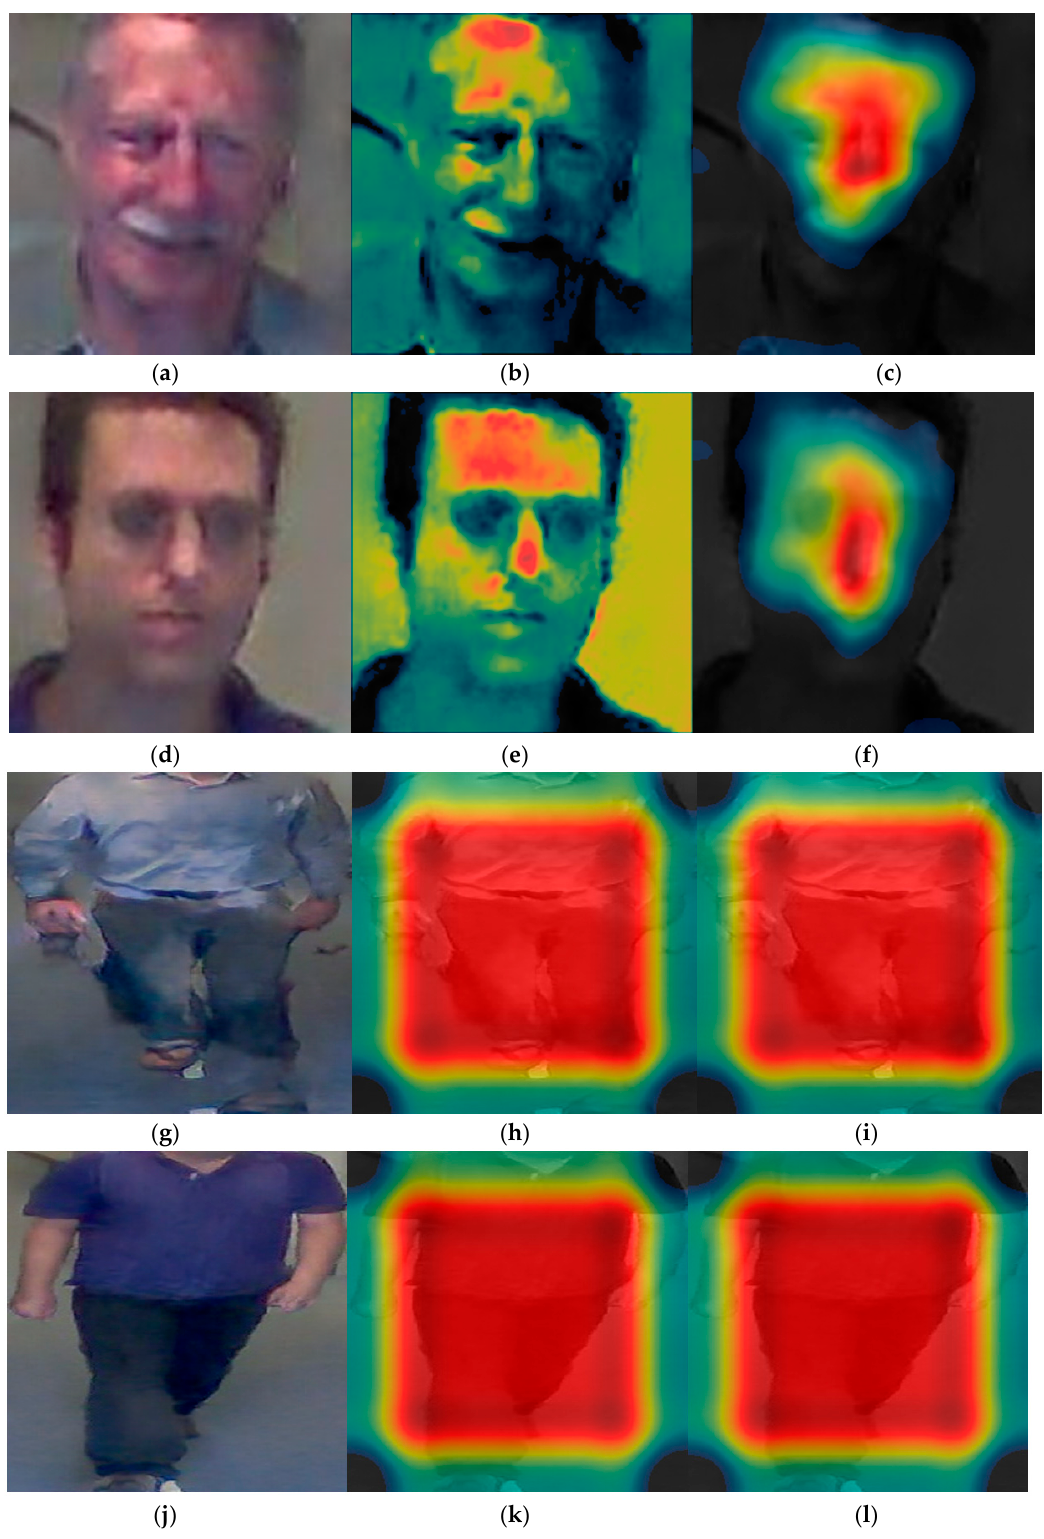
Figure 20. Result on class activation feature map on ChokePoint dataset. ( a , d ) Input face images, ( b , c , e , f ) results for the VGG face net-16 in ReLU layer, ( b , e ) images from 7th ReLU layer, ( c , f ) images from 13th ReLU layer, ( g , j ) input body images, ( h , i , k , l ) results for the ResNet-50 in batch normalized layer, ( h , i ) images from the last batch normalized layer on conv5 2nd block, and ( k , l ) images from the last batch normalized layer on conv5 3rd block.